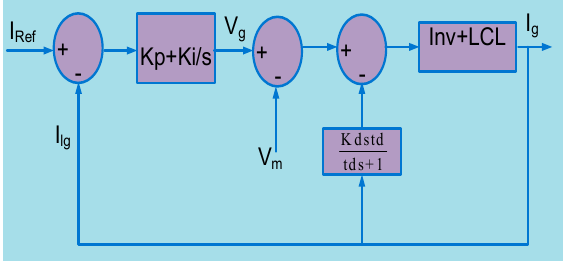
Figure 12. Block Diagram of two degrees of freedom controller.